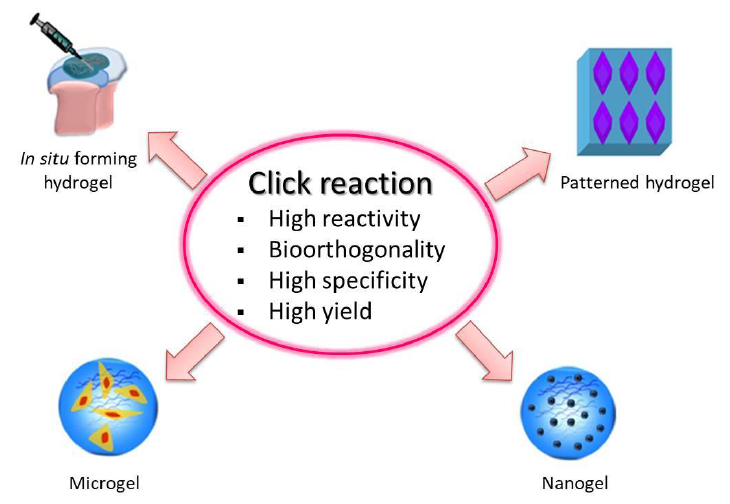
Figure 6. Properties of oxi-HA/ADH hydrogels and classes of biomedical applications: in situ forming hydrogel, patterned hydrogel scaffolds, microgels, and nanogels. (Reproduced with permission from Elsevier (Jiang et al., 2014)).